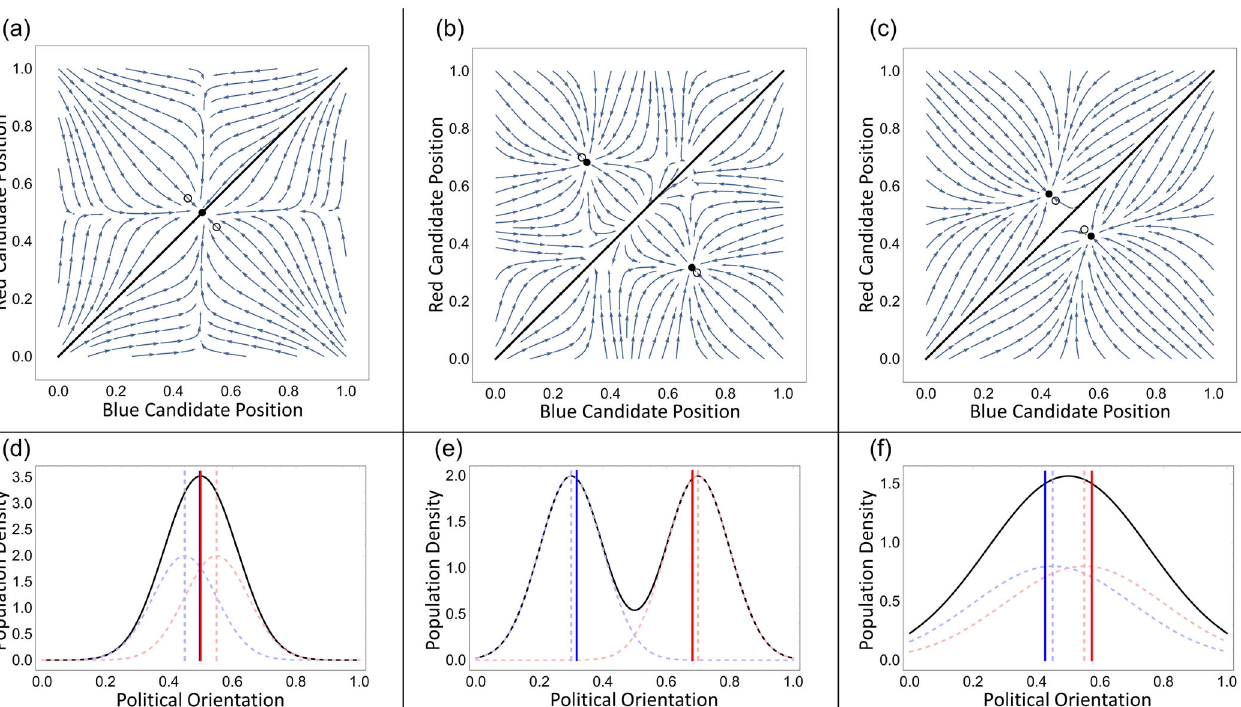
Fig. 4 Optimal behavior of two competing major candidates in different population distributions. a – c show how candidates will shift their position in a stream plot, with the black dot representing the candidates ’ equilibria, and the circles showing the subpopulation peaks. d – f show the corresponding populations in black, the two subpopulations with dashed curves, the subpopulation centers represented by dashed vertical lines, and the candidate equilibrium positions represented by solid vertical lines. We see three types of behavior: candidates converging to the median voter ( a , d ), candidates less polarized than the population ( b , e ), and candidates more polarized than the population ( c , f ). All plots use a reasonable set of parameters P = 2, Q = 30, and R =